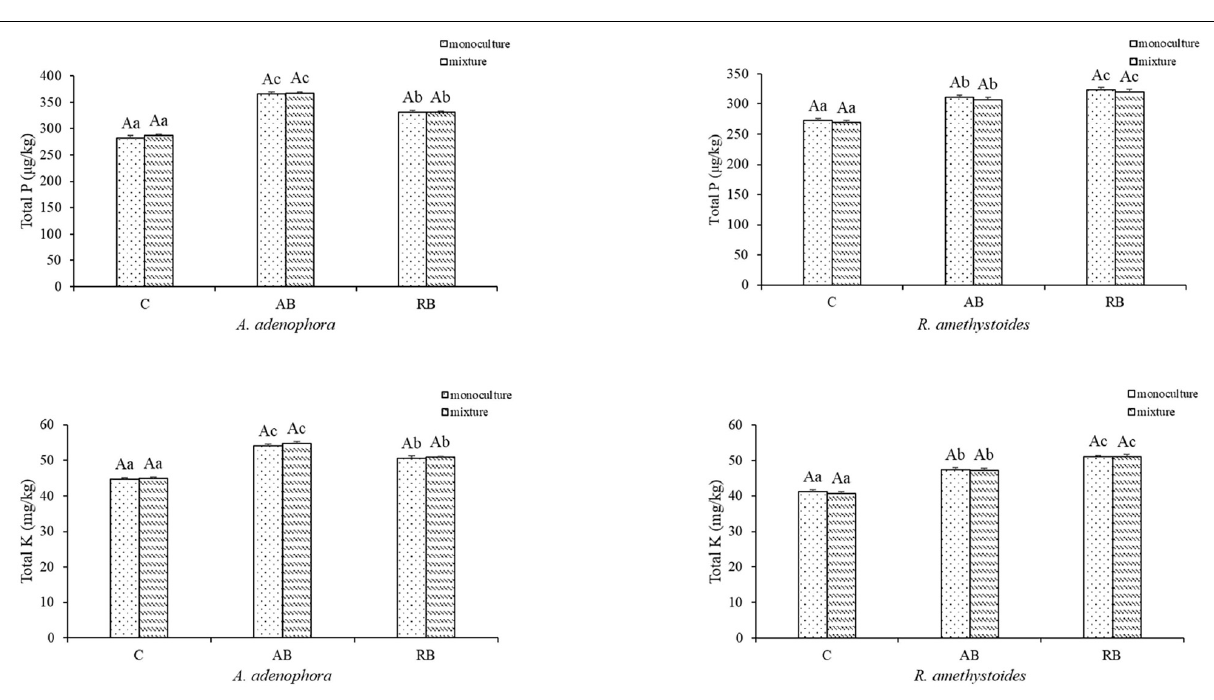
Frontiers in Plant Science |